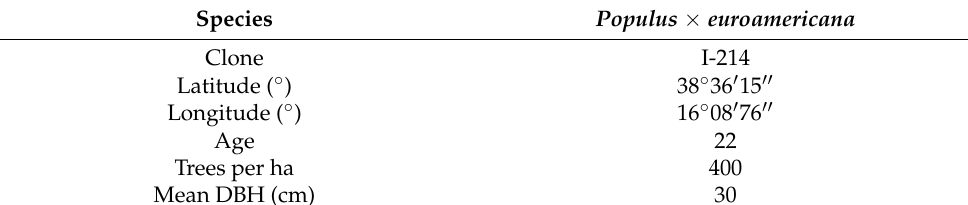
Table 1. Main characteristics of the stand.